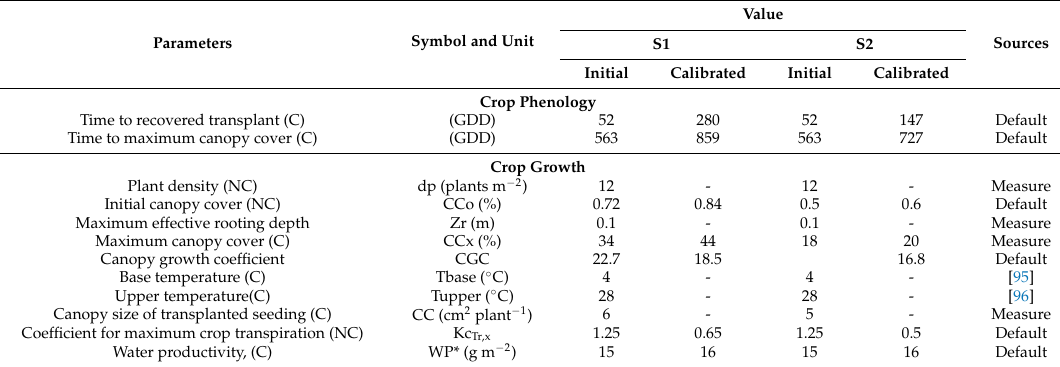
Table 5. AquaCrop variables